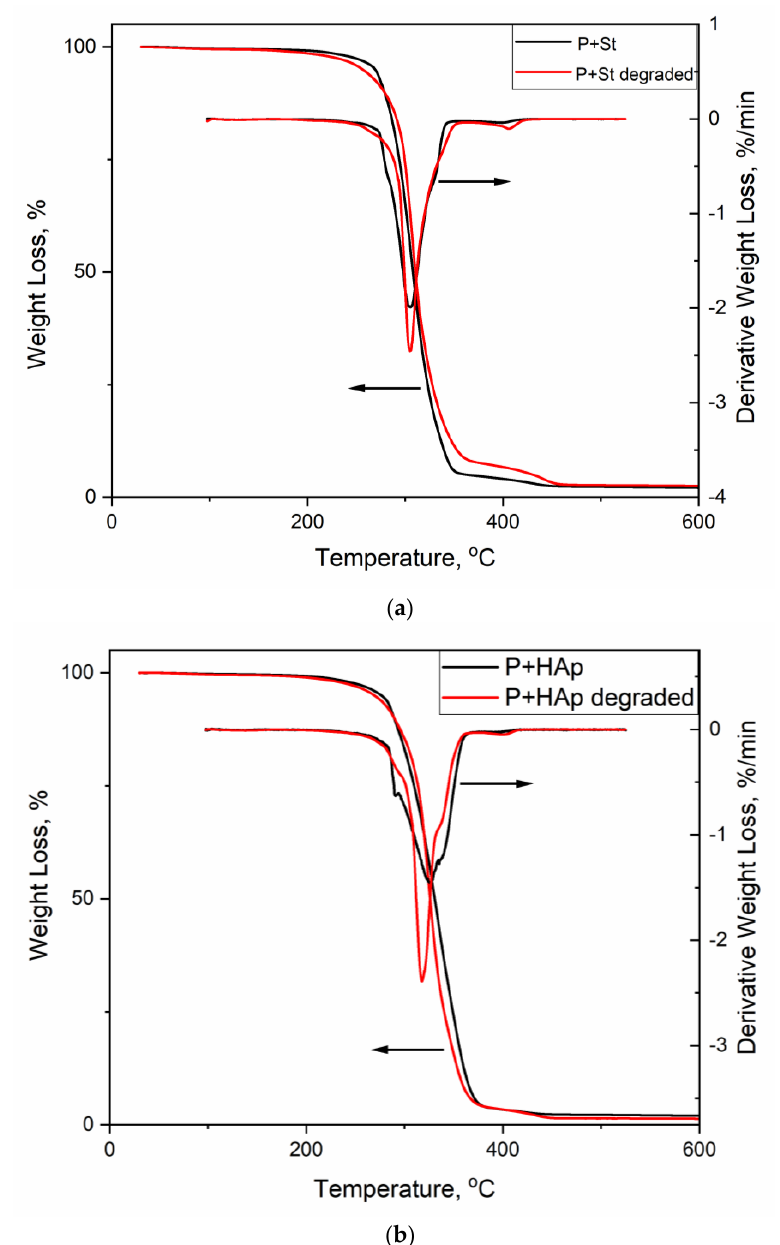
Figure 10. Comparison of the thermogravimetric analysis (TGA) curves of the P + St ( a ) and P + HAp ( b ) films before (red) and after 21 days of degradation (black). Weight loss—left scale, derivative weight loss—right